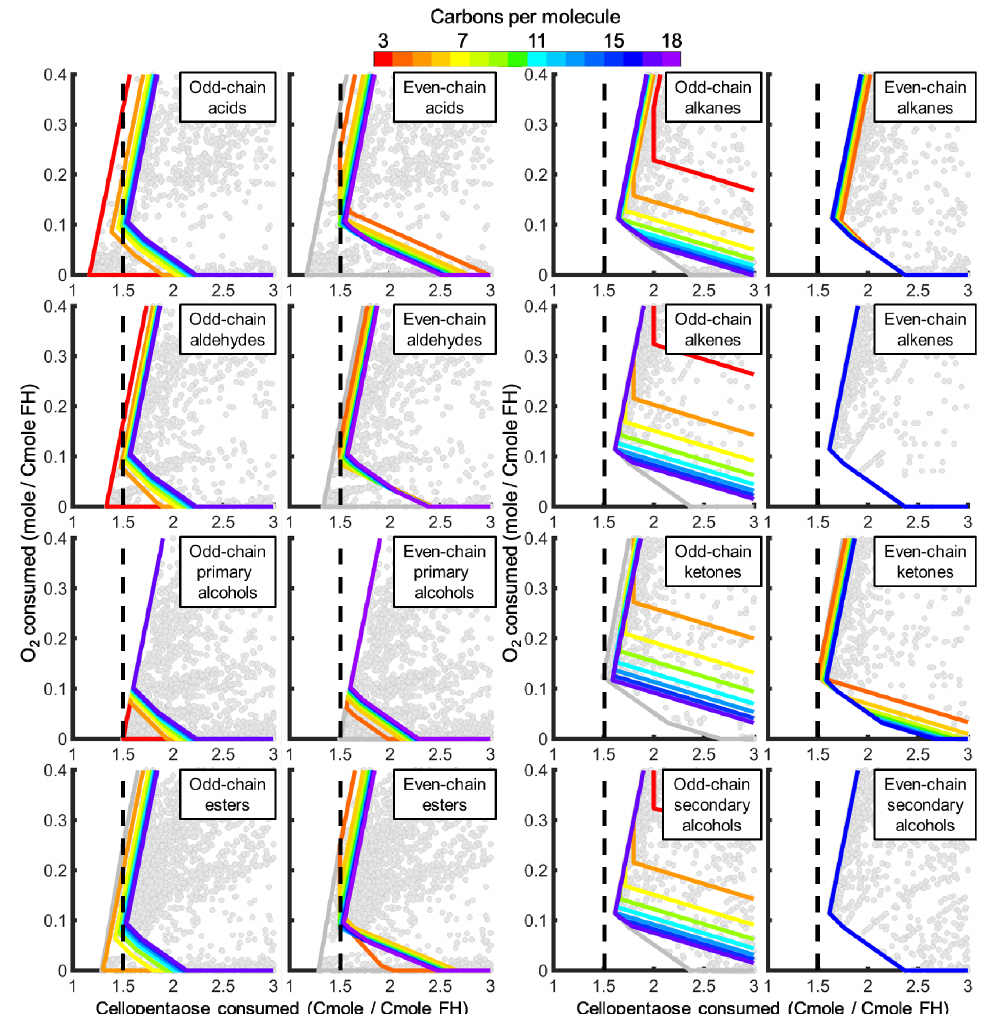
Figure 5. Fatty acid derivative production strategies that minimize carbon and O 2 consumption in A. sarcoides NRRL 50072. Optimal O 2 and carbon source utilization strategies that produce functionalized hydrocarbons (FHs) were identified to minimize resource costs (grey boundary, all possible metabolic strategies, elementary flux modes, and grey points). The colored lines denote metabolic strategies that produce FHs with a given number of carbons per molecule. Formate, acetate, acetaldehyde, and ethanol were not considered to be FHs for this study. Odd and even chain primary functional groups were initiated by propanoyl-CoA and acetyl-CoA, respectively, while the inverse is true for secondary functional groups. Resource profiles for even chain alkanes, even chain secondary alcohols appear as lines due to overlap. A reference carbon resource cost of 1.5 Cmole per Cmole of FH is denoted by the vertical dashed line to facilitate comparisons.